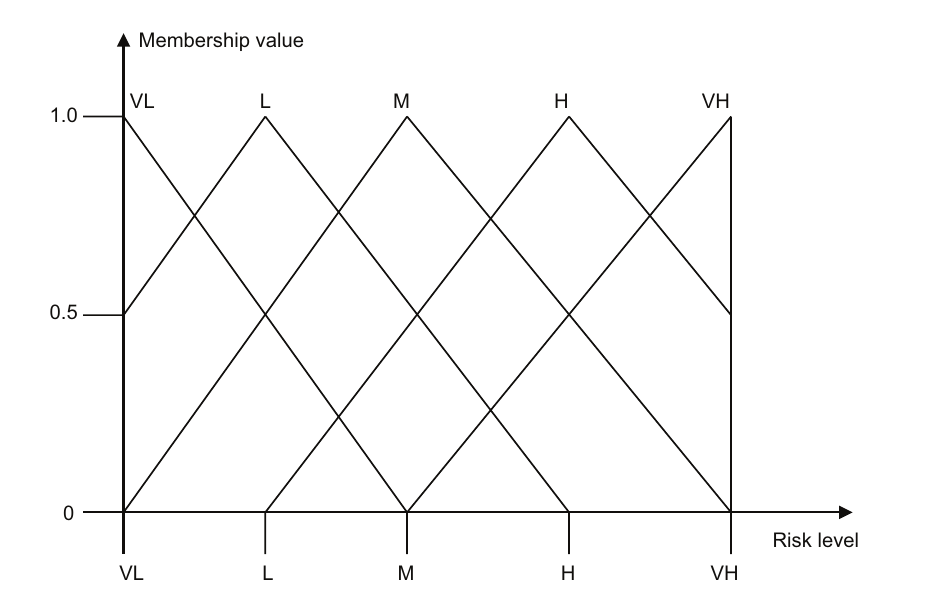
figure 2. Membership functions of evaluation set